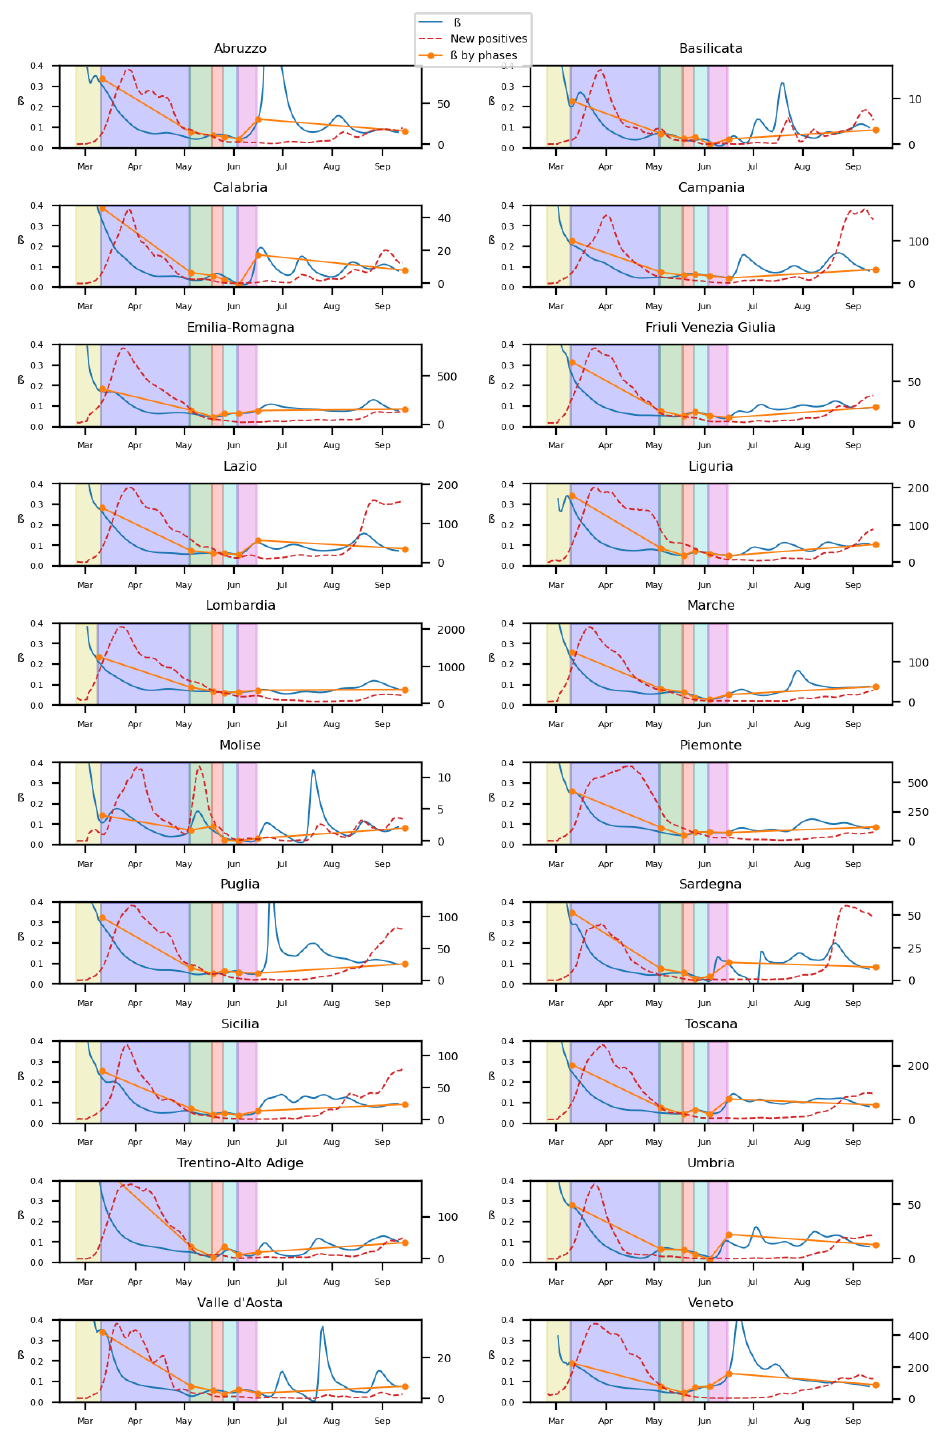
Figure 2. The y axis on the left on each subfigure correspond to the parameter β , while the one on the right to the number of new registered infectious. Each background color represents a different stage of lockdown of Italy: Lockdown, phase 1,2,3,4. White background correspond to pre-lockdown and normality. Red dotted line: The value of new infected individuals at that day . Blue thin line: A 15-days average of β at that day calculated from Equation (8). Orange thick line: A linear regression of β during each